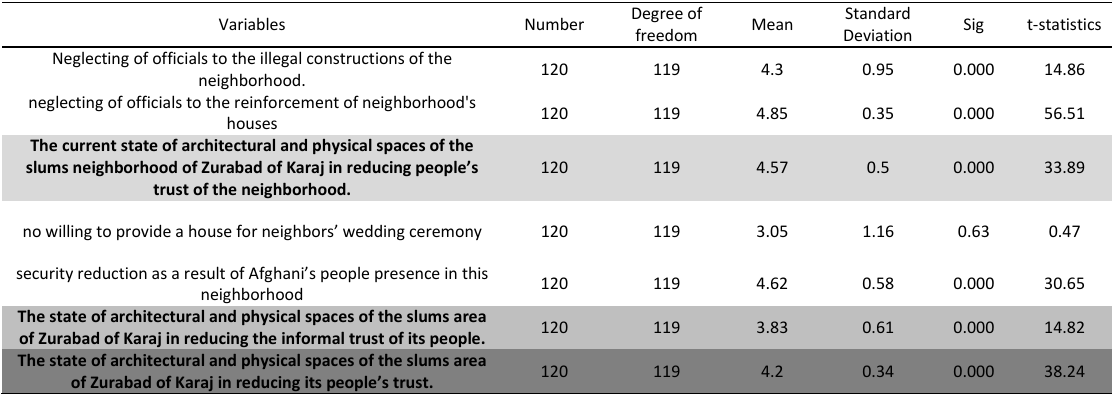
Table 4: Test results for the current state of physical and architectural spaces of the slums area of Zurabad of Karaj in reducing people’s trust (formal-informal of the neighborhood. Degree of Standard Variables Number Mean Sig freedom Deviation